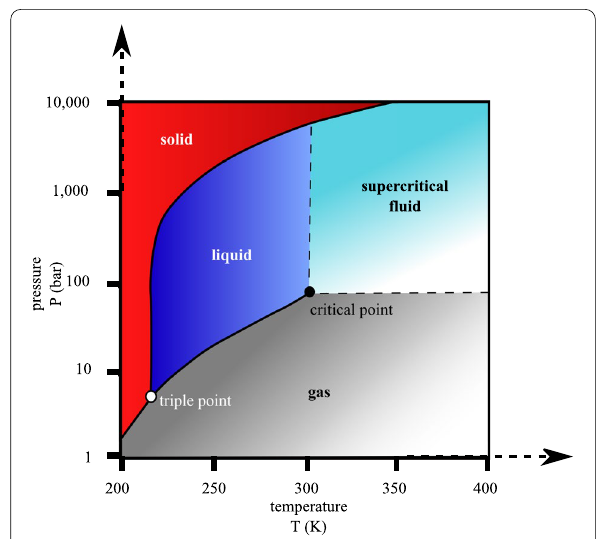
Fig. 3 CO 2 pressure–temperature phase diagram, the critical temperature is 304.13 K or 31.0 °C or 87.8°F, and the critical pressure is 7.3773 MPa or 72.8 atm or 1070 psi or 73.8 bar. (Adopted from Wikimedia commons URL: https:// upload. wikim edia. org/ wikip edia/ commo ns/1/ 13/ Carbon_ dioxi de_ press ure- tempe rature_ phase_ diagr am.